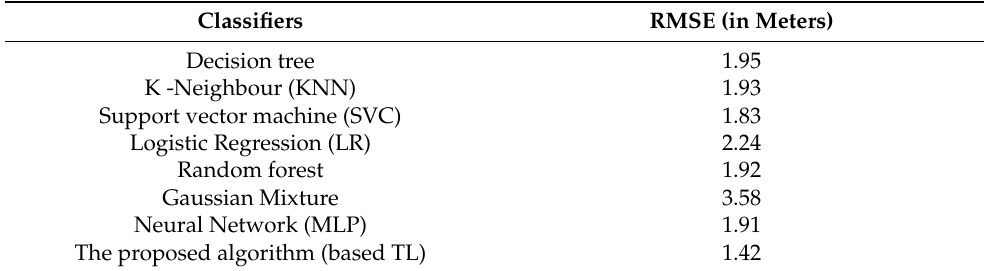
Table 10. Models’ target prediction using the new feature spaces of 6 Wi-Fi access points based on OHetTLAL.